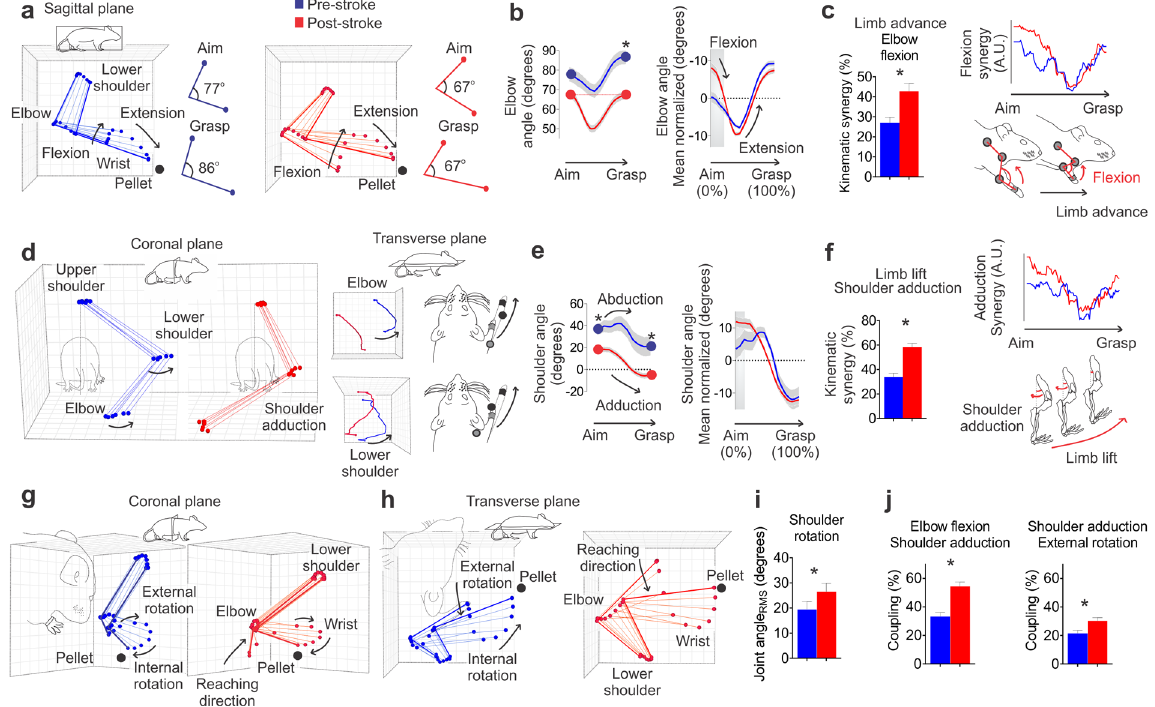
Figure 4. Abnormal elbow flexion, shoulder adduction and rotation kinematic synergy following stroke. ( a ) Representation of elbow angles in the sagittal plane throughout the reach. Elbow flexion is used to lift the paw before advancing the limb toward the target and elbow extension is used to extend the paw towards the pellet (black arrows). (b, left panel) Animals displayed greater elbow extension at grasp position relative to aim position pre-stroke; however, following stroke aim and grasp angles are similar. (b, right panel) During the first segment of the reach, animals show greater elbow flexion. ( c ) Prior to stroke, elbow movement involves increased extension during limb advance (decreased elbow flexion synergy); however after stroke animals display increased elbow flexion throughout limb advance (increased elbow flexion synergy; left panel). Further, the increased flexion synergy occurred mainly during the first half of the reaching movement (right panels). ( d ) Pre-stroke reaching involves medio-lateral elbow and lower shoulder movement to facilitate pronation of the limb during the reach. Black arrows indicate these elbow and shoulder movements in both the coronal (left panel) and transverse planes (right panels). (e, left panel) Following stroke the shoulder is more adducted during the aim and grasp. Pre-stroke movement uses shoulder abduction to transport the limb, while post- stroke movement displays adduction only (black arrows). (e, right panel) Specifically, animals showed increased shoulder adduction during the beginning of the reach. ( f ) Post-stroke animals display increased shoulder adduction synergy during limb lift (left panel) that was more evident during the first half of the reaching movement (right panels). ( g – i ) Shoulder rotation movements were increased following stroke, and were characterized by increased shoulder external and internal rotation angles (shown in two different views: coronal, g ; and transverse, h ). ( i ) Root mean square of shoulder internal/external rotation angle. ( j ) Abnormal coupling between elbow flexion/shoulder adduction and shoulder adduction/external rotation were evident post-stroke. Mean traces and stick figures (n = 13). Paired t-test, * p < 0.05, mean, or mean ±